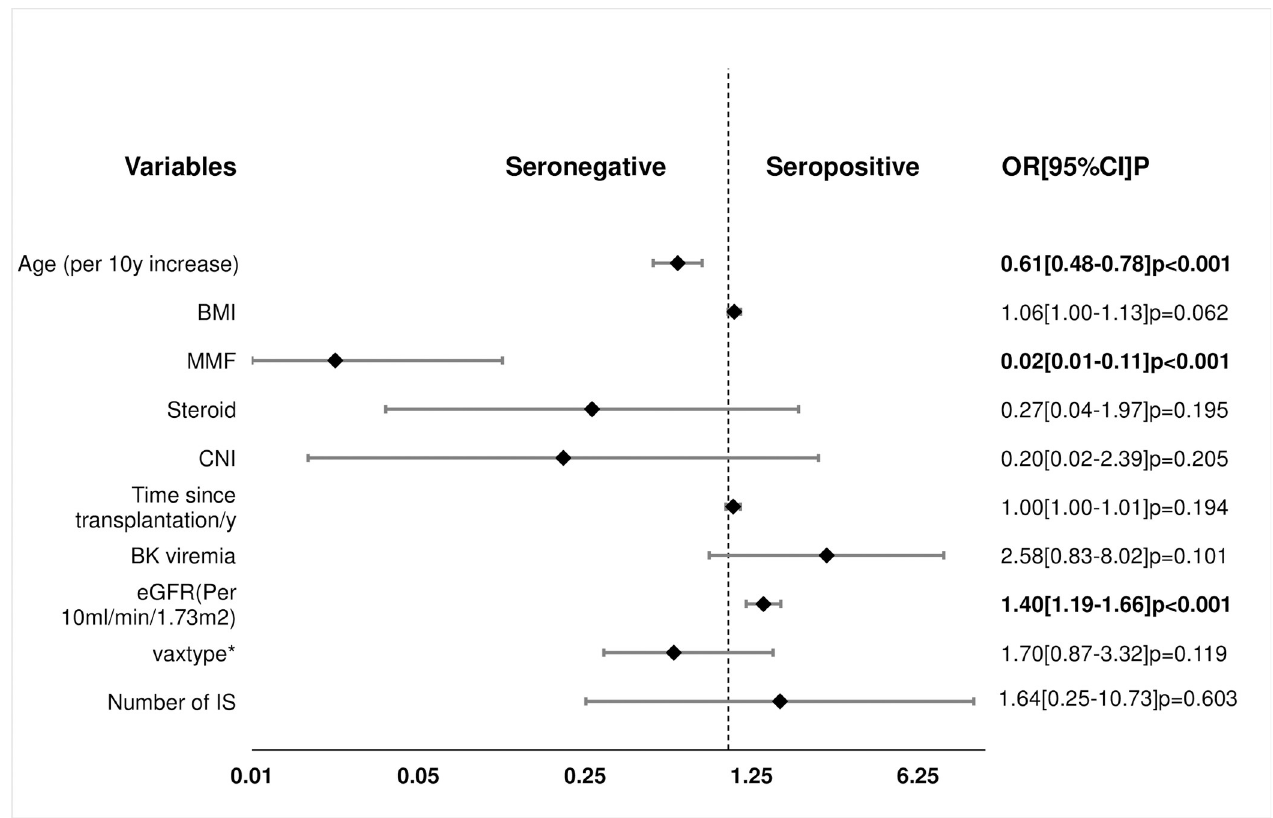
Fig 2. Factors associated with vaccine response by multivariate analysis. a, MDRD eGFR mL/min/1.73 m2; CVD, cardiovascular disease; � , AZD1222, Oxford/AstraZeneca vaccine vs BNT162b2, Pfizer-BioNTech vaccine.